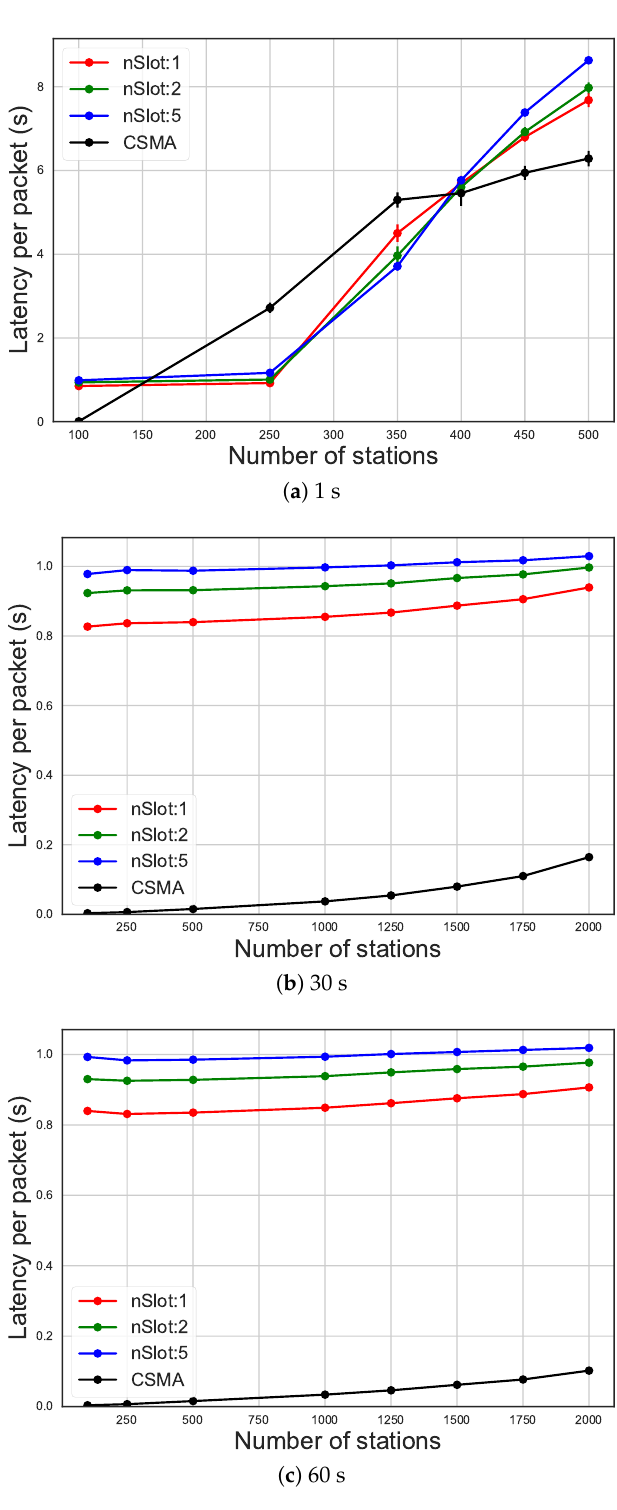
Figure 9. Latency of different packet arrival intervals, comparing CSMA/CA and the usage of 10 RAW groups and 1, 2 and five slot per